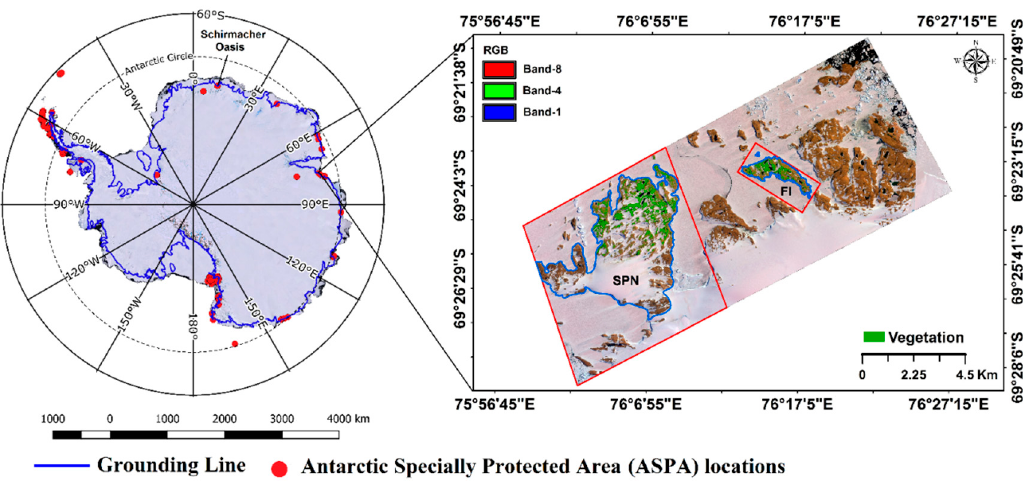
Figure 1. A WorldView-2 (WV-2) satellite image [(Band 8 (860–1040 nm), Band 4 (585–625 nm), Band 1 (400–450 nm)] showing the location of the Larsemann Hills in the Landsat Image Mosaic of Antarctica (LIMA). A reference manually digitized (and cross-verified using ground surveying) vegetation cover map showing the spatial location of vegetation over the Fisher Island and Stornes Peninsula (SPN), Larsemann Hills and environs. Locations of the subsets showing the study areas under consideration are highlighted with red colored boxes, while the boundaries of Stornes Peninsula and Fisher Island are depicted with a blue colored polygon. The location of the cross-validation site at Schirmacher Oasis in East Antarctica is also highlighted.